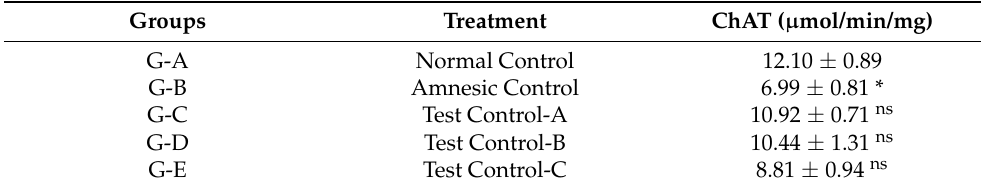
Table 5. Estimation of choline acetyltransferase levels in mice